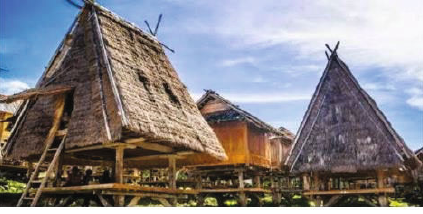
Figure 15: Uma Lengge